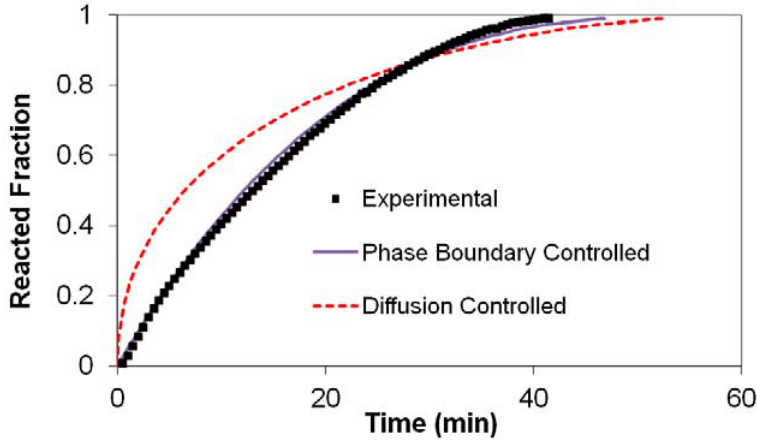
Figure 9. Modeling results for MgH